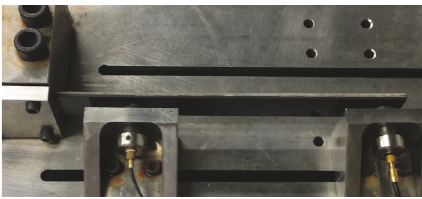
Figure 1: The Oberst beam test bench.